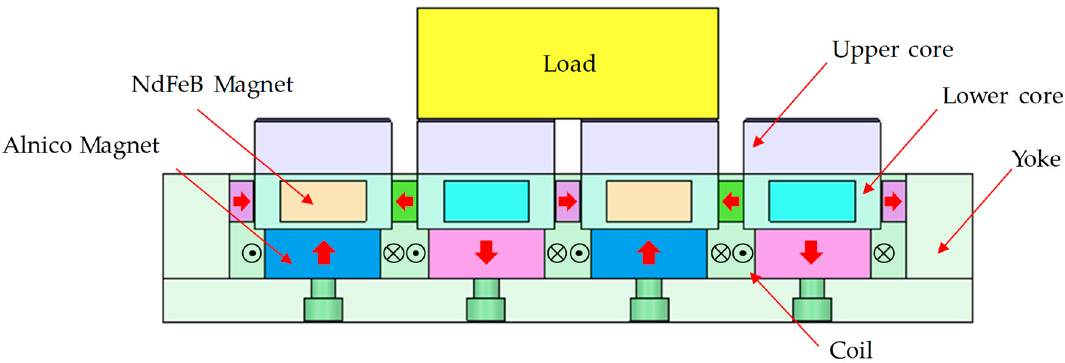
Figure 6. Cross-sectional structure of conventional H-EMMs.